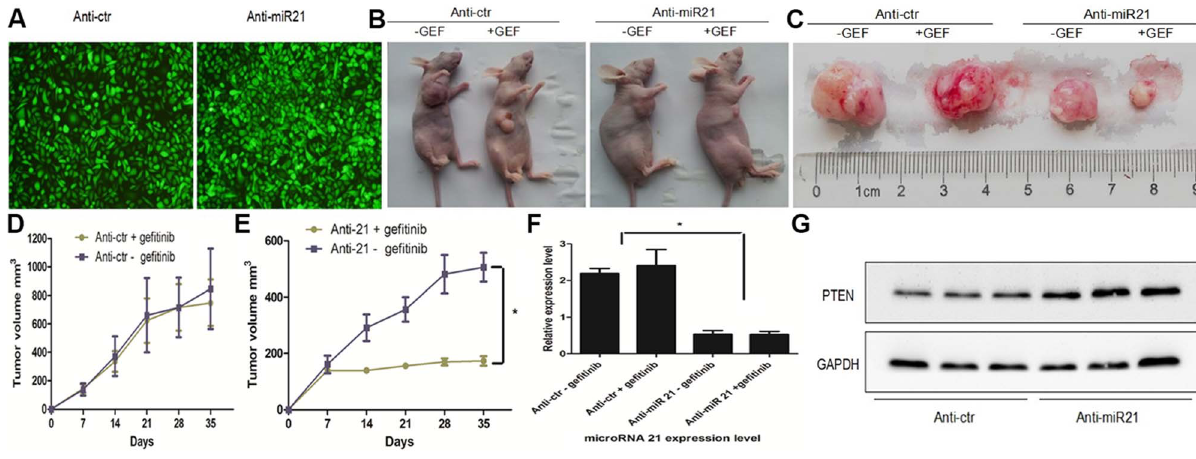
Figure 6. Anti-miR-21 restored gefitinib sensitivity of pc-9/GR invivo . (A) Fluorescent pictures of pc-9/GR cells transfected by inhibitors of control miRNAs (ctr) or miR-21. (B) Representative tumor engraftments in nude mice injected with pc-9/GR cells stably transfected with anti-Ctr, anti- 21. 35 days after injection and following treatment with vehicle (0.1% tween 80) or gefitinib (200 mg/kg), mice were sacrificed. The images show one representative mouse in each category. (C) Comparison of engrafted tumors in nude mice injected with pc-9/GR cells stably transfected with inhibitors of control miRNAs (ctr) or miR-21. The images show representative tumors in each category. (D) Tumor growth curve upon implantation of pc-9/GR + anti-Ctr cells with vehicle or gefitinib. (E) Tumor growth curve upon implantation of pc-9/GR + anti-miR-21 cells with vehicle or gefitinib. (F) qRT-PCR showing miR-21 down-regulation in pc-9/GR xenografts infected by anti-miR-21 compared with pc-9/GR cells infected by anti-Ctr. *P , 0.01. (G) Pten protein levels in xenograft tumors analyzed by western-blot.